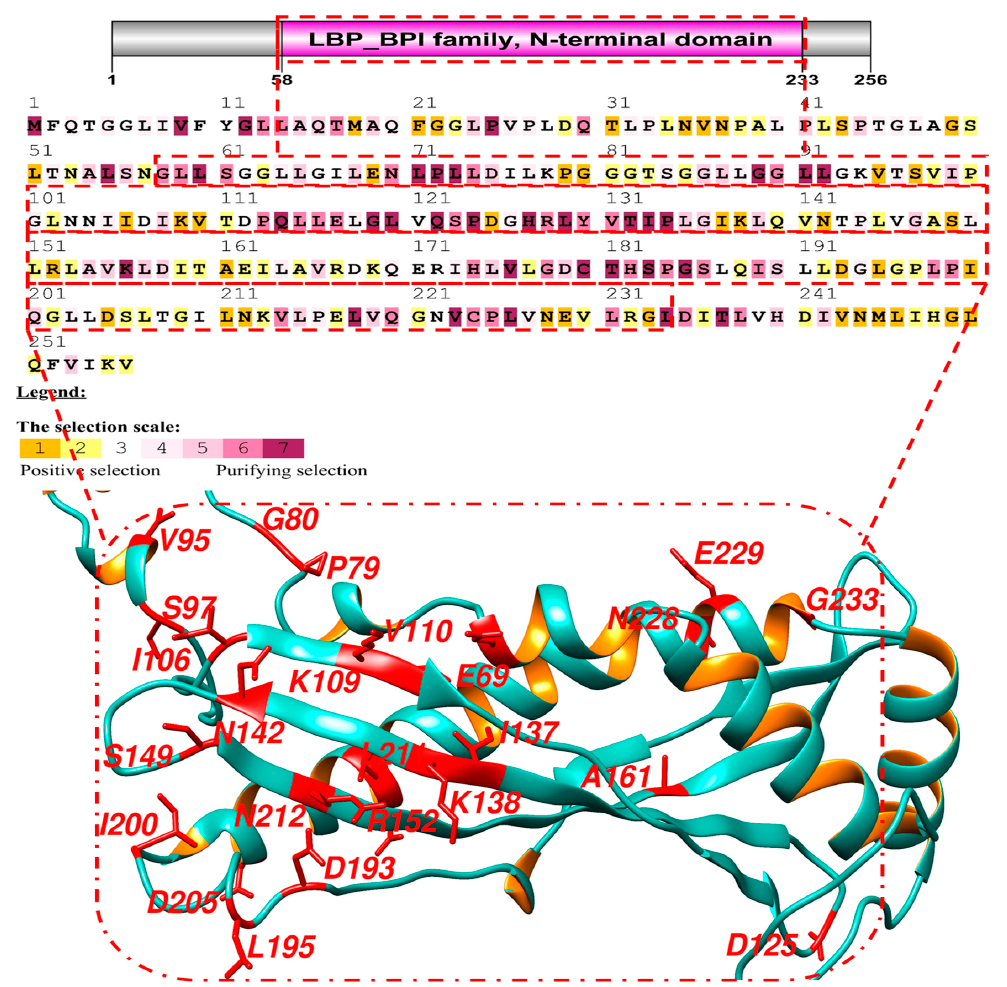
Figure 1. Results of adaptive selection on 20 primate BPIFA1 sequences using the MEC model. The human protein was used as a reference. Positive selection is indicated by yellow and magenta, whereas purifying selection is represented by blue and